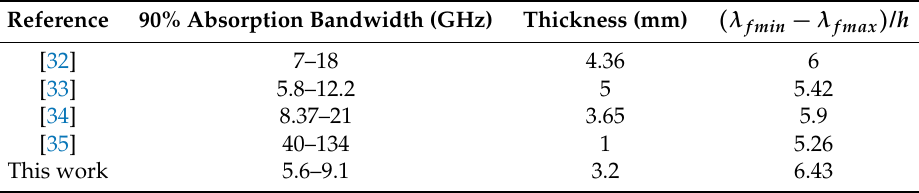
Table 1. Performance comparison of our absorber with some other absorbers.